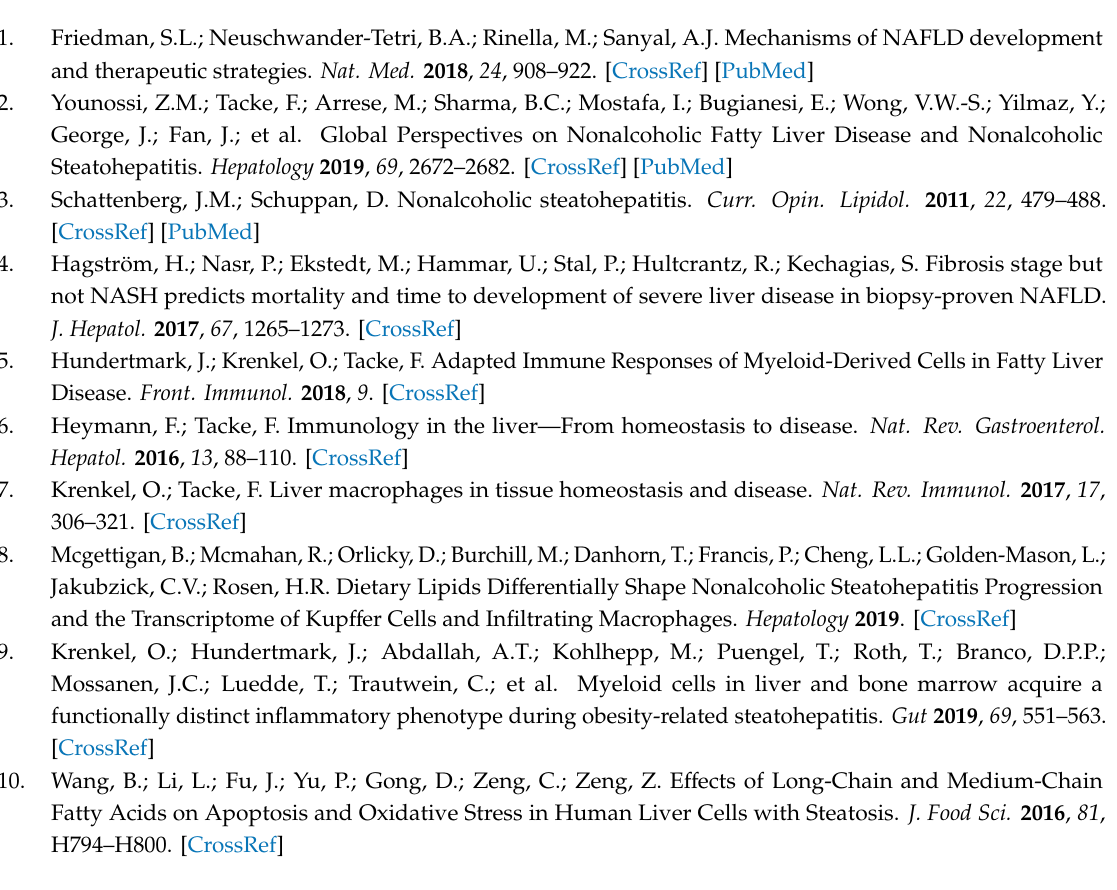
Figure S1. Immune cells in MCD diet induced steatohepatitis and fibrosis. Figure S2. Immune cells in CCl4 induced liver